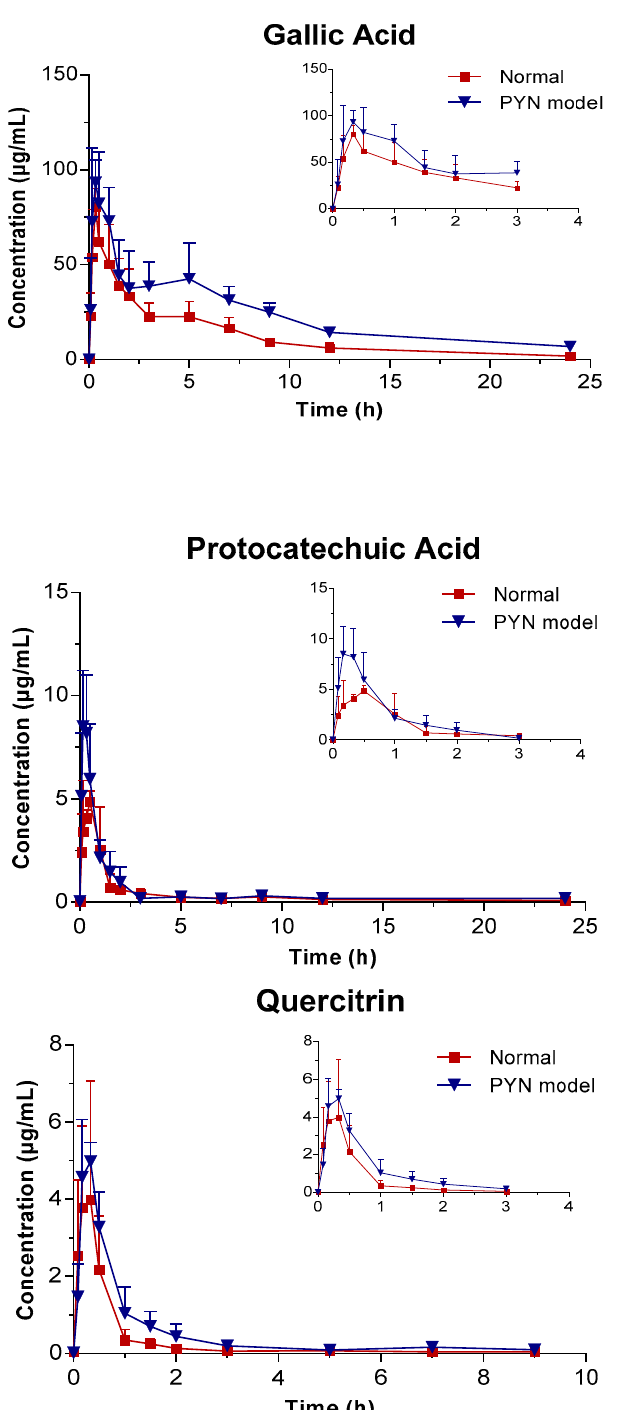
Figure 3. Mean plasma concentration vs. time profile of the three components following the oral administration of Polygonum capitatum extract in normal and PYN model rats (mean ± SD, n =